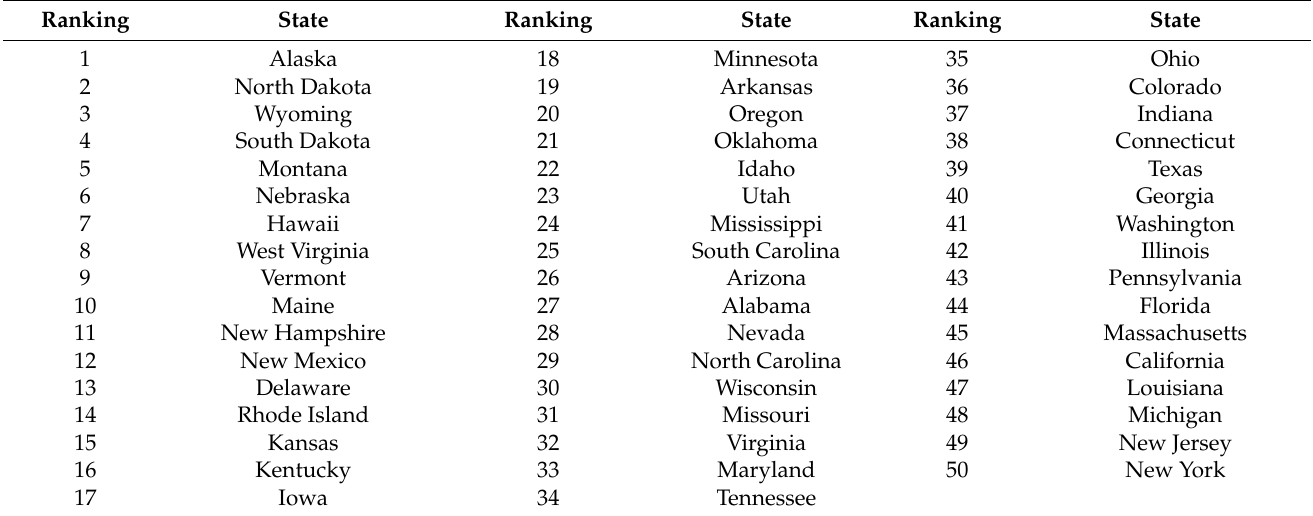
Table 5. State rankings of the average daily positive increase ( K i